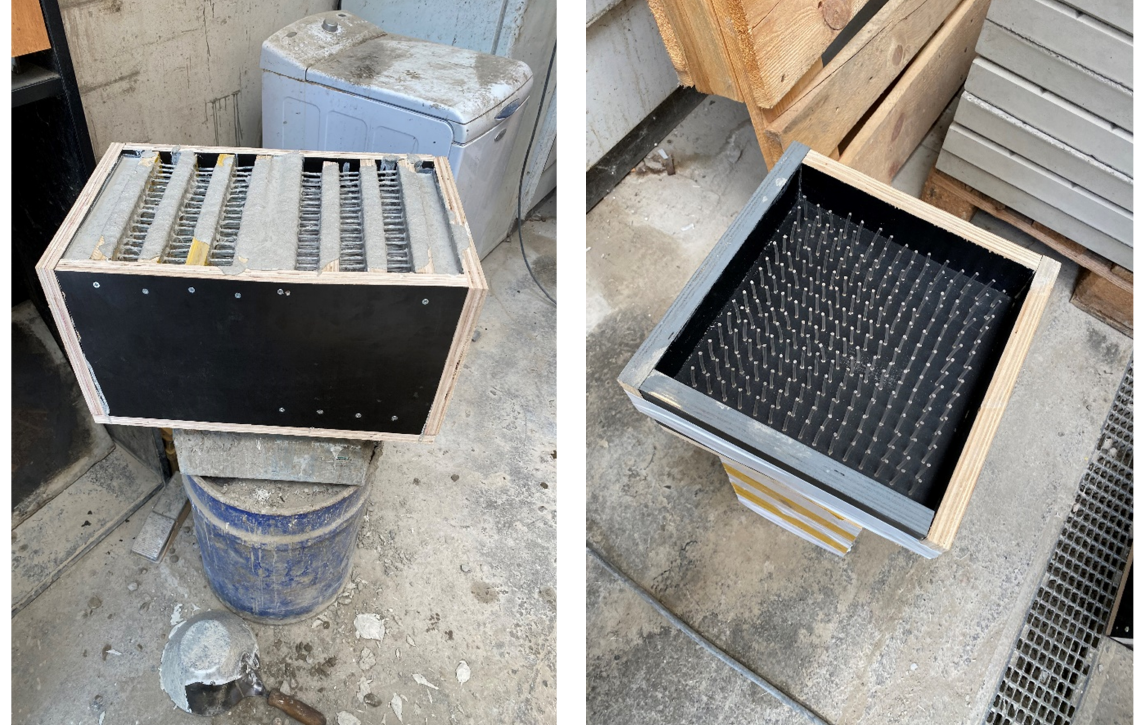
Figure 14. Formwork for making samples.